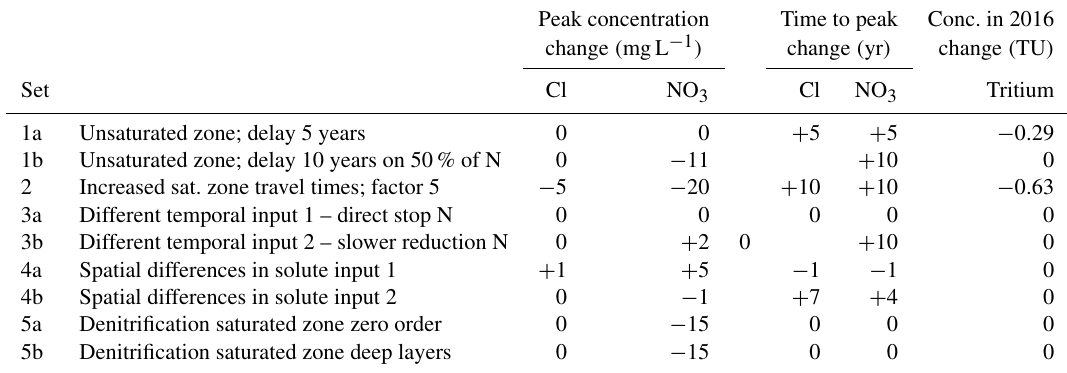
Figure 5. The effect on tritium (a) , chloride (b) , and nitrate (c) in the upstream part of the catchment of a scenario with a 5-year delay due to an unsaturated zone, a scenario in which part of the input of N was delayed and a scenario in which all travel times were increased by a factor of 5. Table 3. Summarized results of the exploration of the model